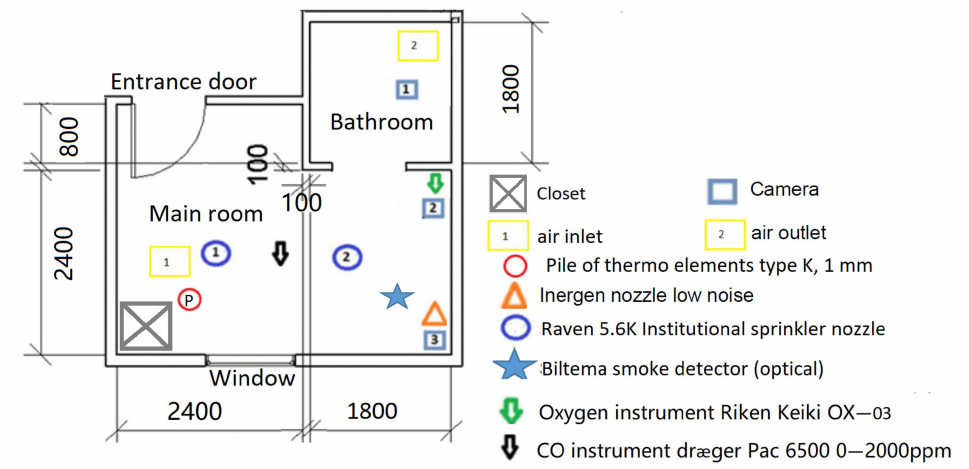
Figure 1. Layout of the apartment (unit: